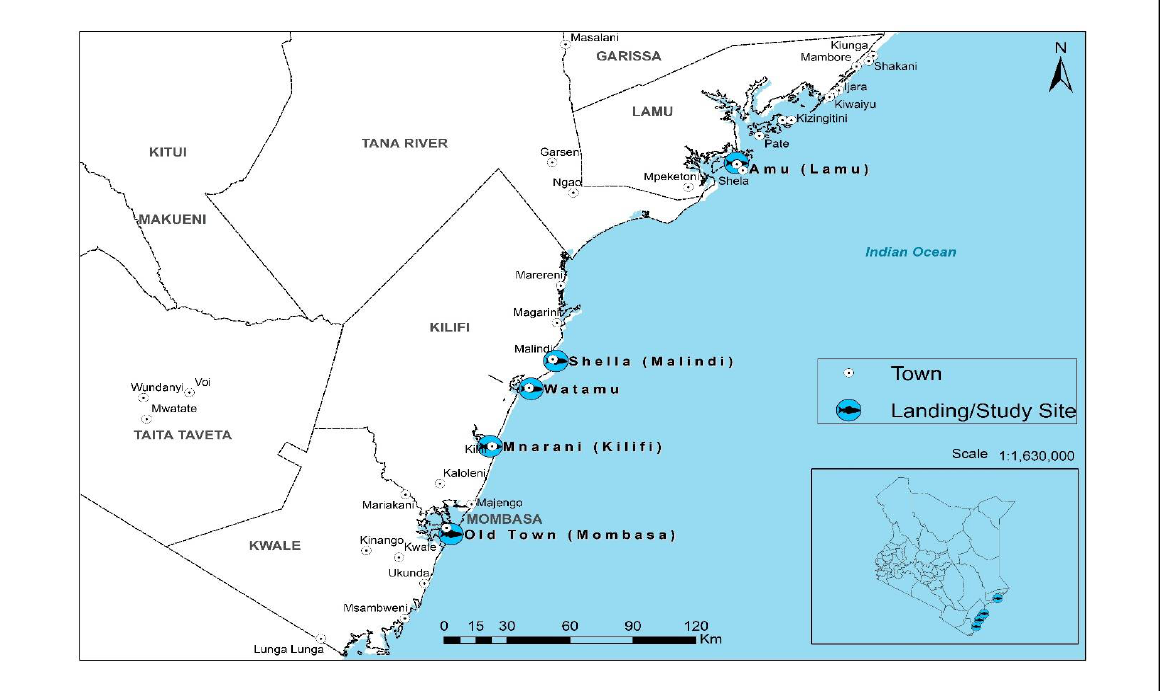
Figure 1: Artisanal Swordfish fishery landing sites used as study